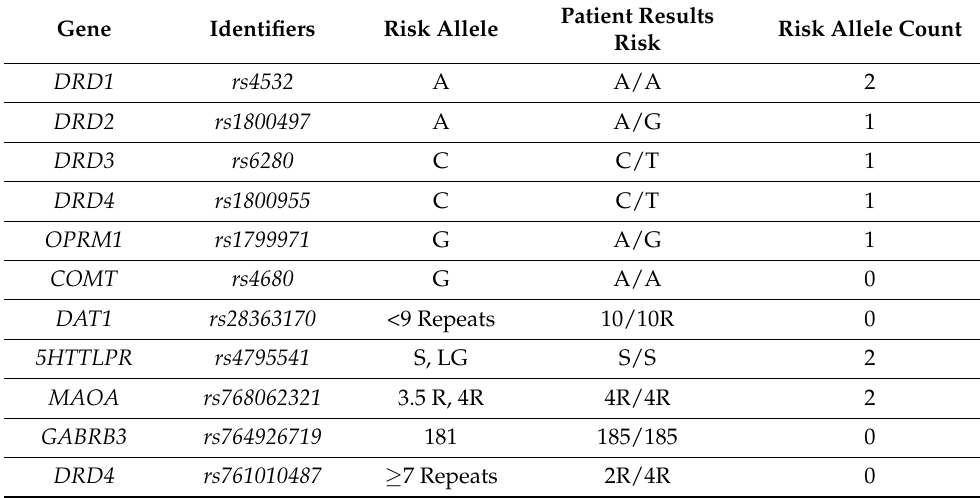
Table 9. Mother’s GARS test results *.